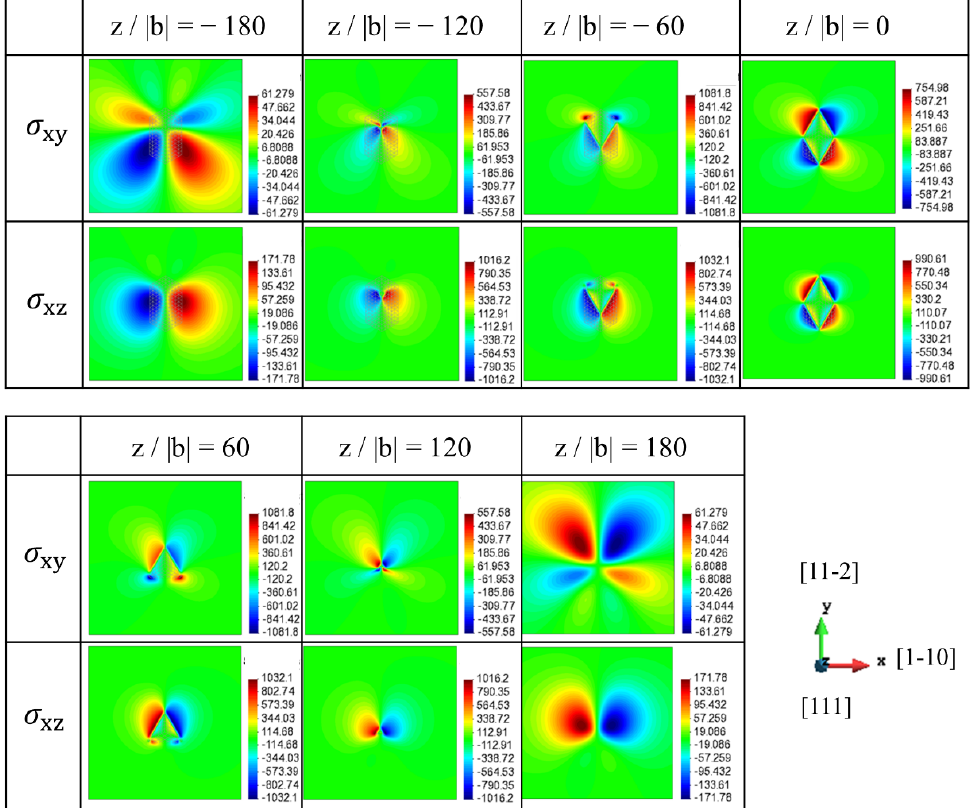
Figure 5. Stress field of [001] rod on the (111) slip plane (Type-A variant). σ xy and σ xz in dislocation coordinate are represented at the different positions (z/|b| = −180 to 180).